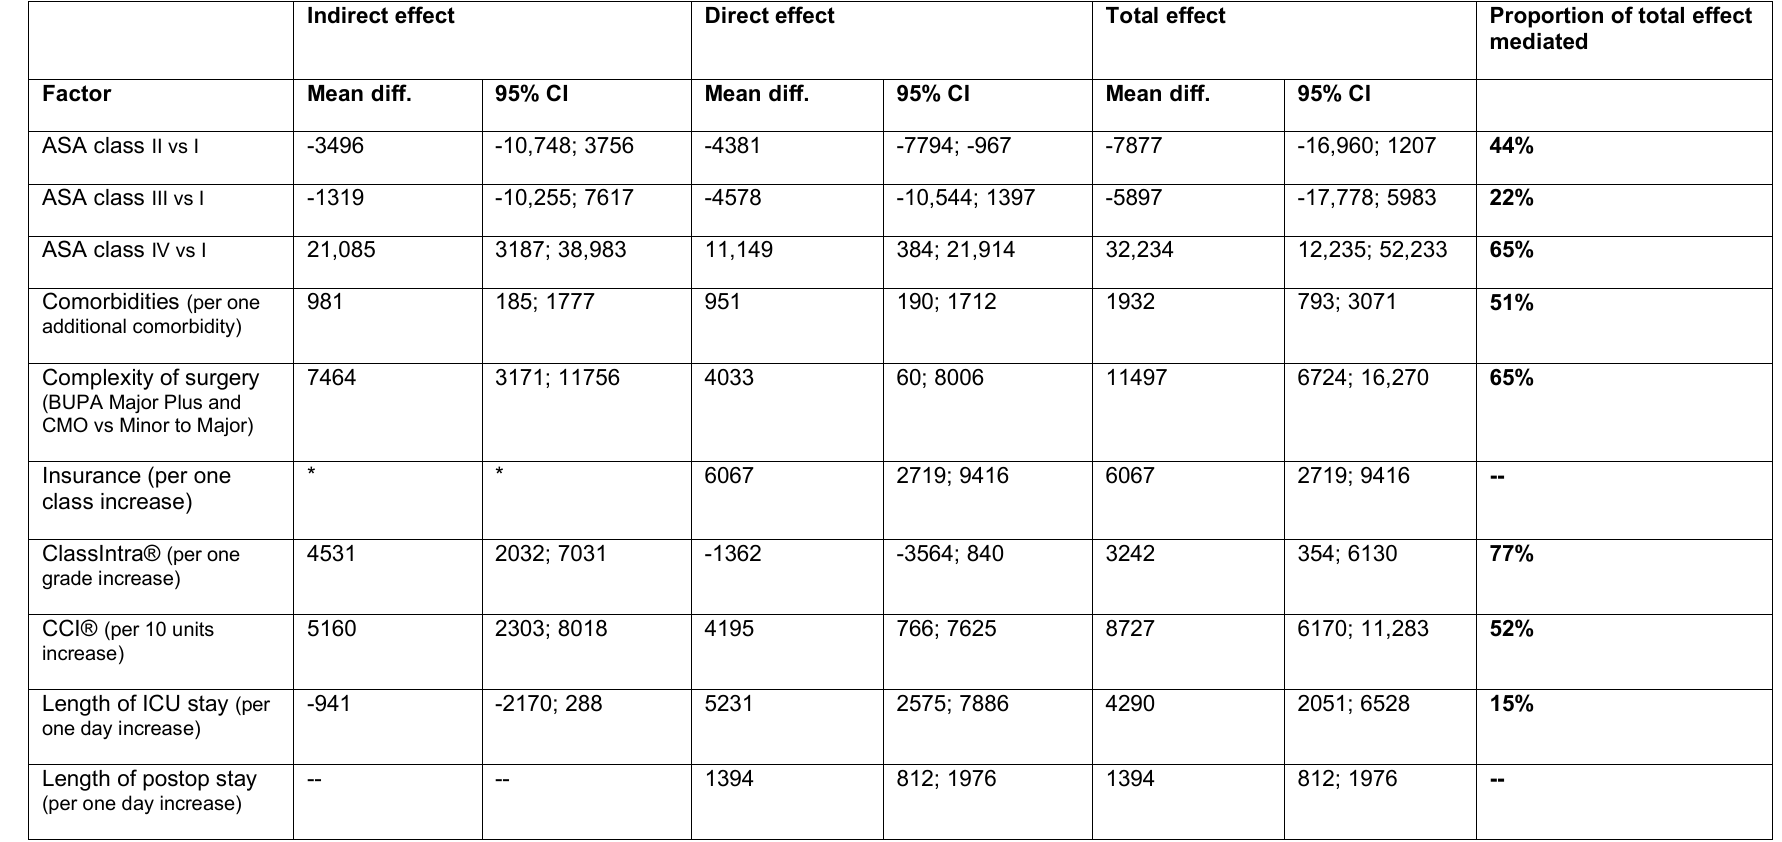
Table 10: Cost model excluding recurrent patients (in Euros) Indirect, direct and total effects on costs. Coefficients are mean differences in cost; patients with protracted hospital or ICU stay were NOT excluded. R-squared 55.2%